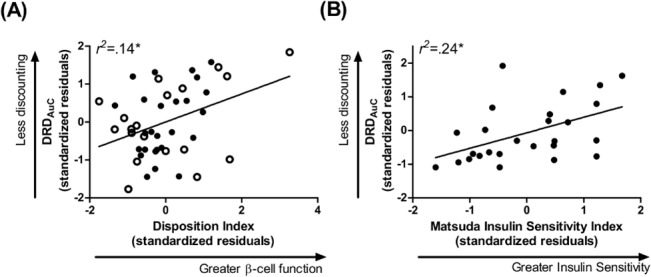
Insulin Function Relates to Delayed Reward Discounting in Total Sample and Obese Group.(A) β-cell function across the total sample and (B), insulin sensitivity in obese participants related to greater preference for a smaller but immediate monetary reward relative to one that was larger but delayed. Data points are standardized residuals of variables after controlling for age, gender, education, and ethnicity (and group in (A)). Clear data points, non-obese; filled data points, obese; DRDAuC, area under the curve for delayed reward discounting.